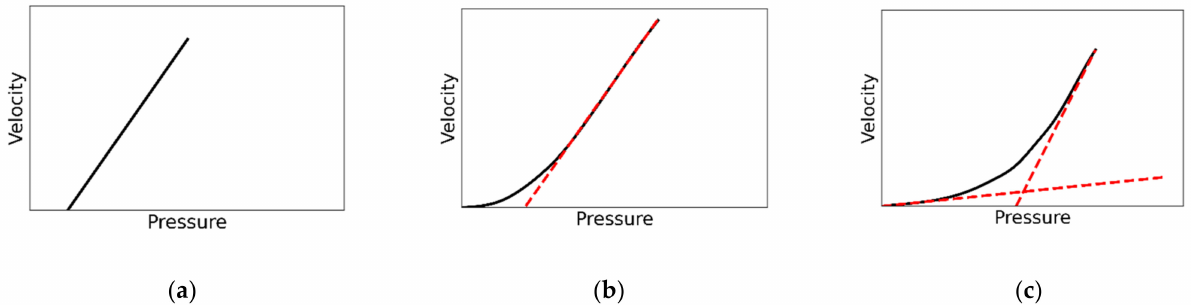
Figure 1. Pre-Darcian, Darcian, and Post Darcian curves—pressure and velocity relationship as grouped by Kutilek [41]. Black continuous line shows the non-linearity of Darcy law. Red-dashed line shows the expected linearity of Darcy law. ( a ) Linear proportionality between pressure and velocity with the curve not passing through the origin. ( b ) A non-linear proportionality between pressure and velocity at lower pressure and a linear proportionality at relatively higher pressure. ( c ) Non-linear proportionality between pressure and